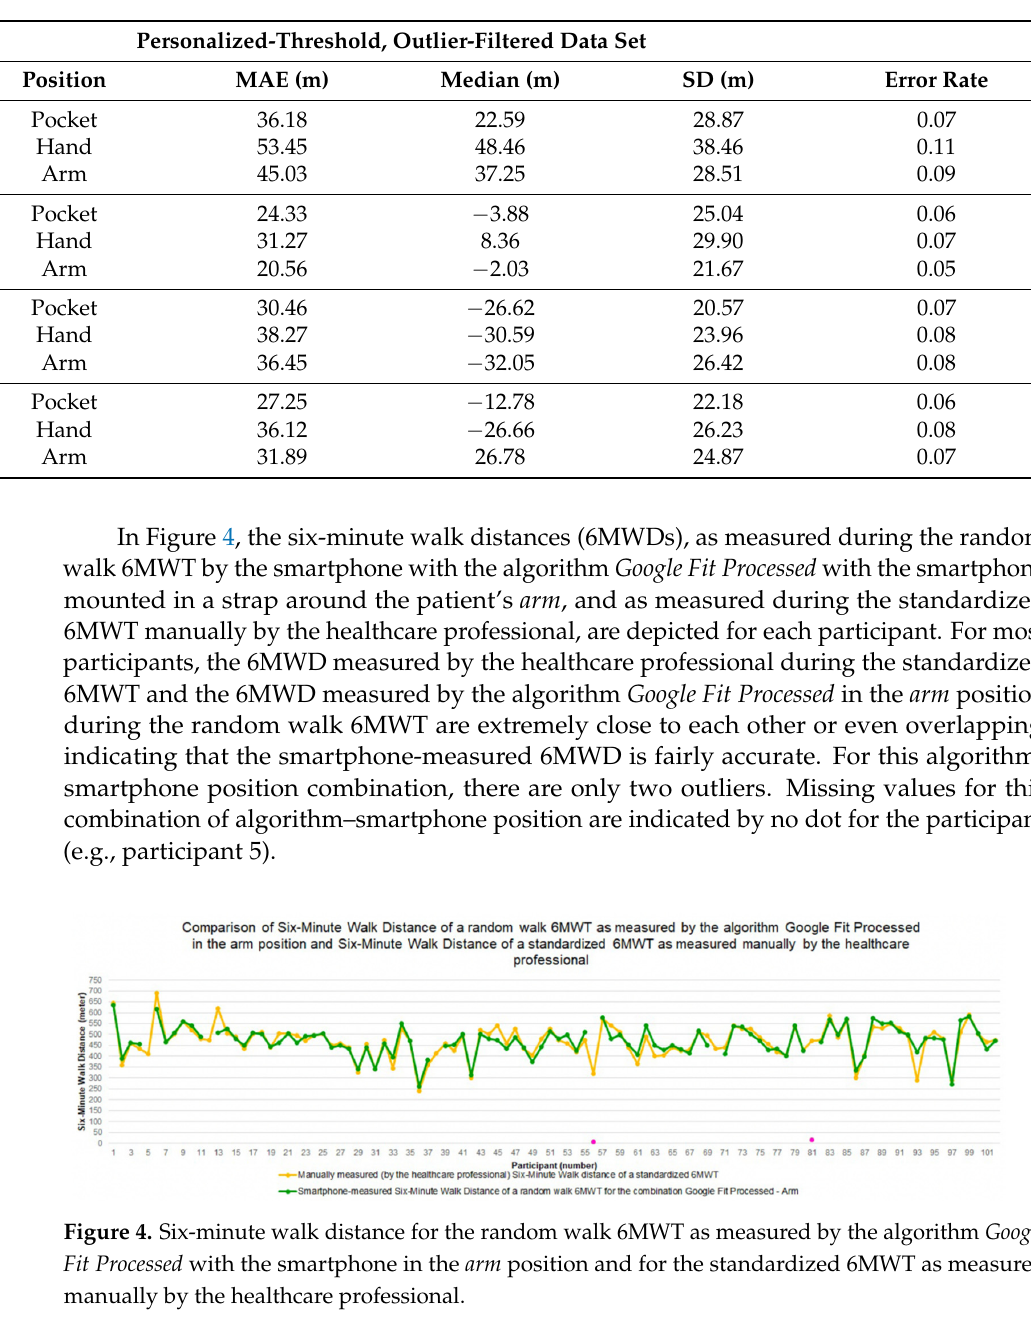
Table 3. Results of the smartphone-measured 6MWDs of a random walk 6MWT using different algorithms and different smartphone positions. MAE: mean absolute error, SD: standard deviation.